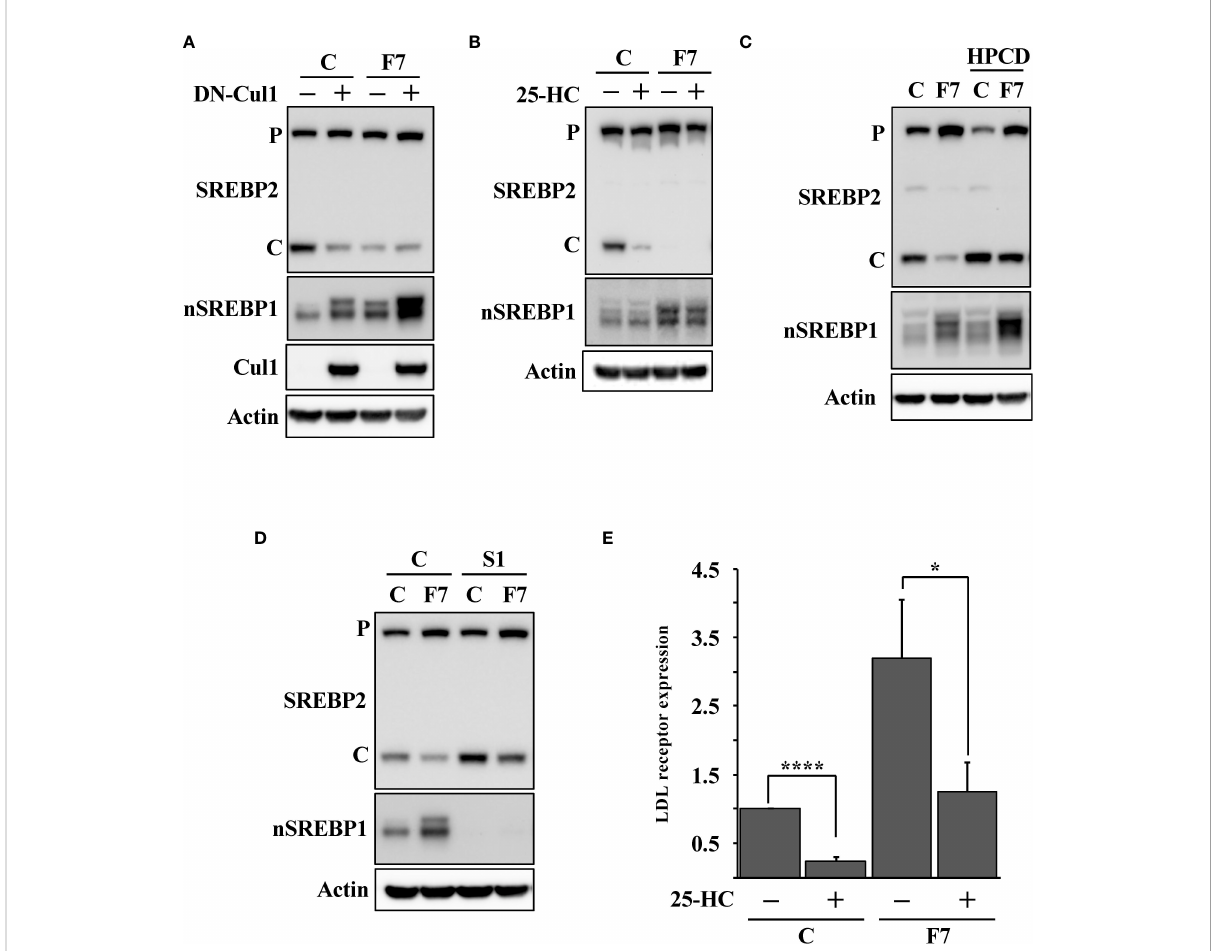
FIGURE 2 Loss of Fbw7 attenuates the maturation of SREBP2. (A) HepG2 cells were transduced with lentiviruses expressing control ( C ) or Fbw7 ( F7 ) shRNA, followed by either GFP or DN-cul1. The levels of SREBP2, nuclear SREBP1 ( nSREBP1 ), cullin 1 ( Cul1 ) and b -actin in total lysates were determined by Western blotting. P and C denotes the precursor and cleaved forms of SREBP2, respectively. (B) HepG2 cells were transduced with control ( C ) or Fbw7 ( F7 ) shRNA, and left untreated or treated with 25-HC for six hours. The levels of SREBP2, nuclear SREBP1 ( nSREBP1 ) and b -actin in total lysates were determined by Western blotting. P and C denotes the precursor and cleaved forms of SREBP2, respectively. (C) HepG2 cells were transduced with control ( C ) or Fbw7 ( F7 ) shRNA and left untreated or treated with HPCD for two hours. The levels of SREBP2, nuclear SREBP1 ( nSREBP1 ) and b -actin in total lysates were determined by Western blotting P and C denotes the precursor and cleaved forms of SREBP2, respectively. (D) HepG2 cells were transduced with control ( C ) or Fbw7 ( F7 ) shRNA, followed by either control ( C ) or SREBP1 ( S1 ) shRNA. The levels of SREBP2, nuclear SREBP1 ( nSREBP1 ) and b -actin in total lysates were determined by Western blotting. P and C denotes the precursor and cleaved forms of SREBP2, respectively. (E) HepG2 cells were transduced and treated as in ( B ). The expression of LDL receptor mRNA was determined by real-time qPCR. P-values lower than 0.05 were considered statistically signi fi cant. *P < 0.05, **P < 0.01, ***P < 0.001, and ****P < 0.0001. NS , not signi fi